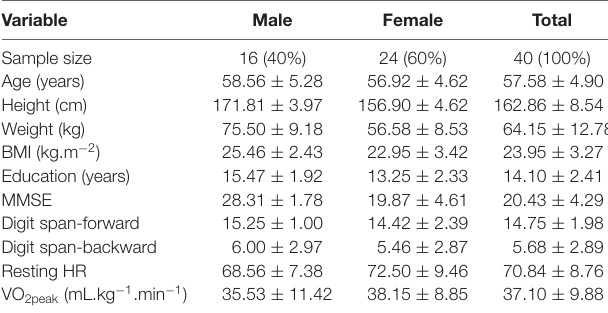
TABLE 1 | Participant characteristics (M ±